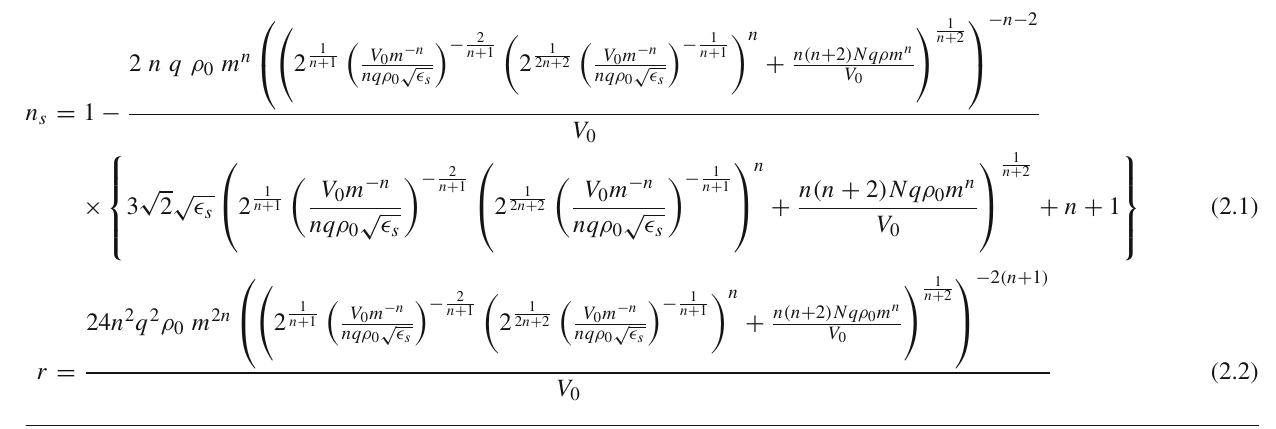
Figs. 1, 2, 3 and 4. All the results quoted in Table 1 satisfies the SC2